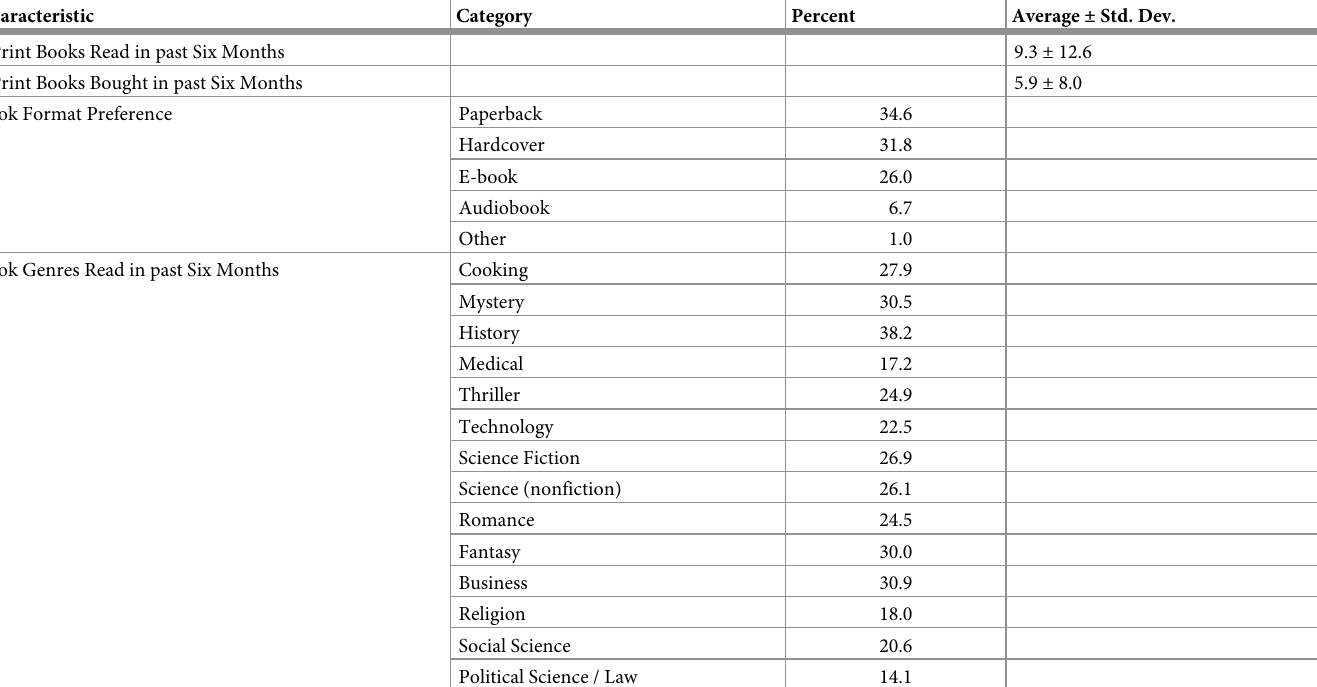
Table 4. Readership characteristics of our experimental subjects. Note that the book genre assignment adds up to > 100% as respondents were able to indicate multiple genres.